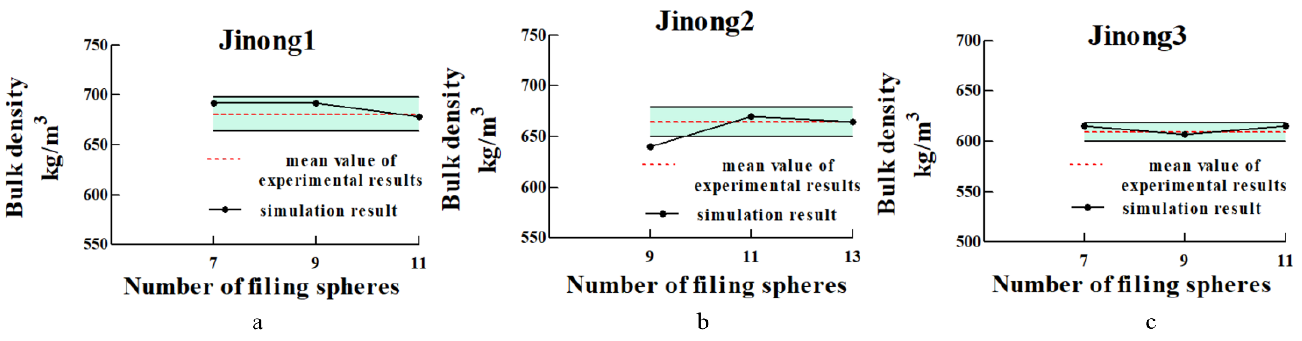
Figure 24. ( a – c ) Variations of the simulated bulk density versus the number of filing spheres for different varieties of seeds. different varieties of